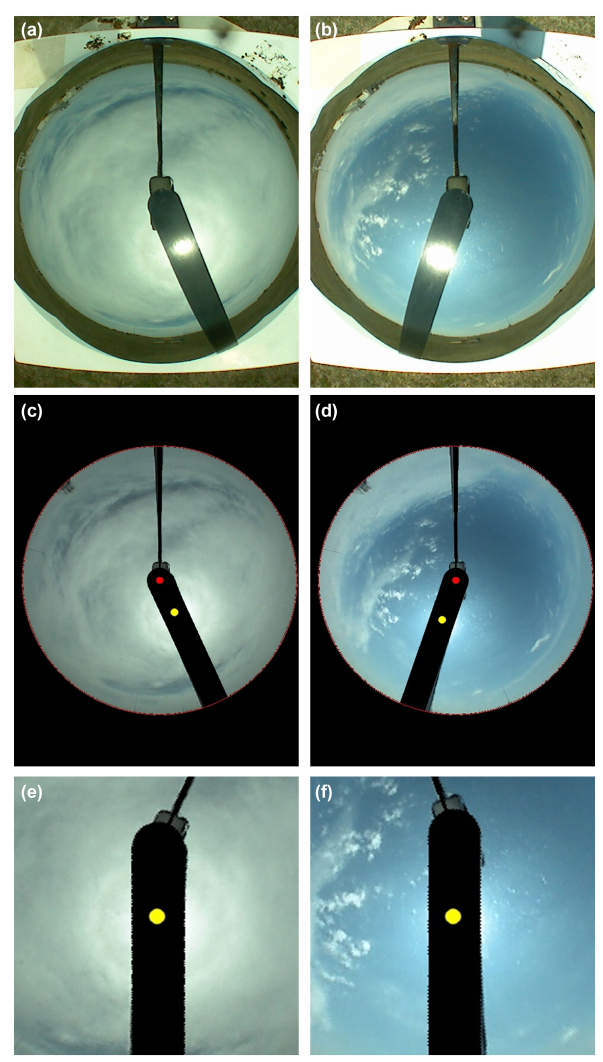
Figure 2. Two examples for image preparation. The left column develops an image from SGP 17 April 2018 17:45:00UTC, and the right image was taken on SGP 3 April 2018 19:09:30UTC. (a, b) Original image; (c, d) image after color correction, distortion removal, masking of horizon and equipment, and sun mark were applied; (e, f) final local sky map with sun at center and a width of about 80 LSM